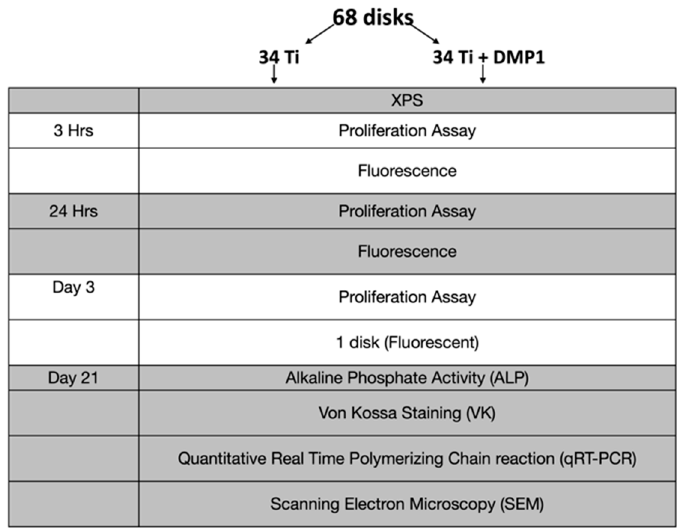
Figure 1. Methodologies summarized flow chart.